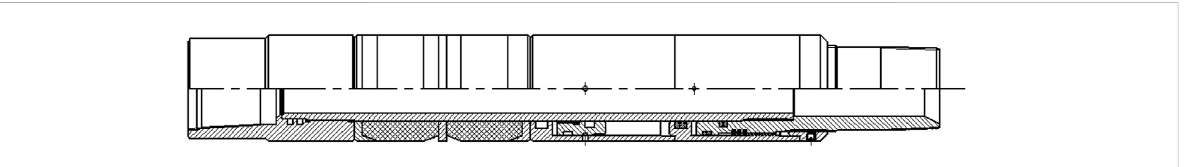
FIGURE 6 Schematic of a compression packer.